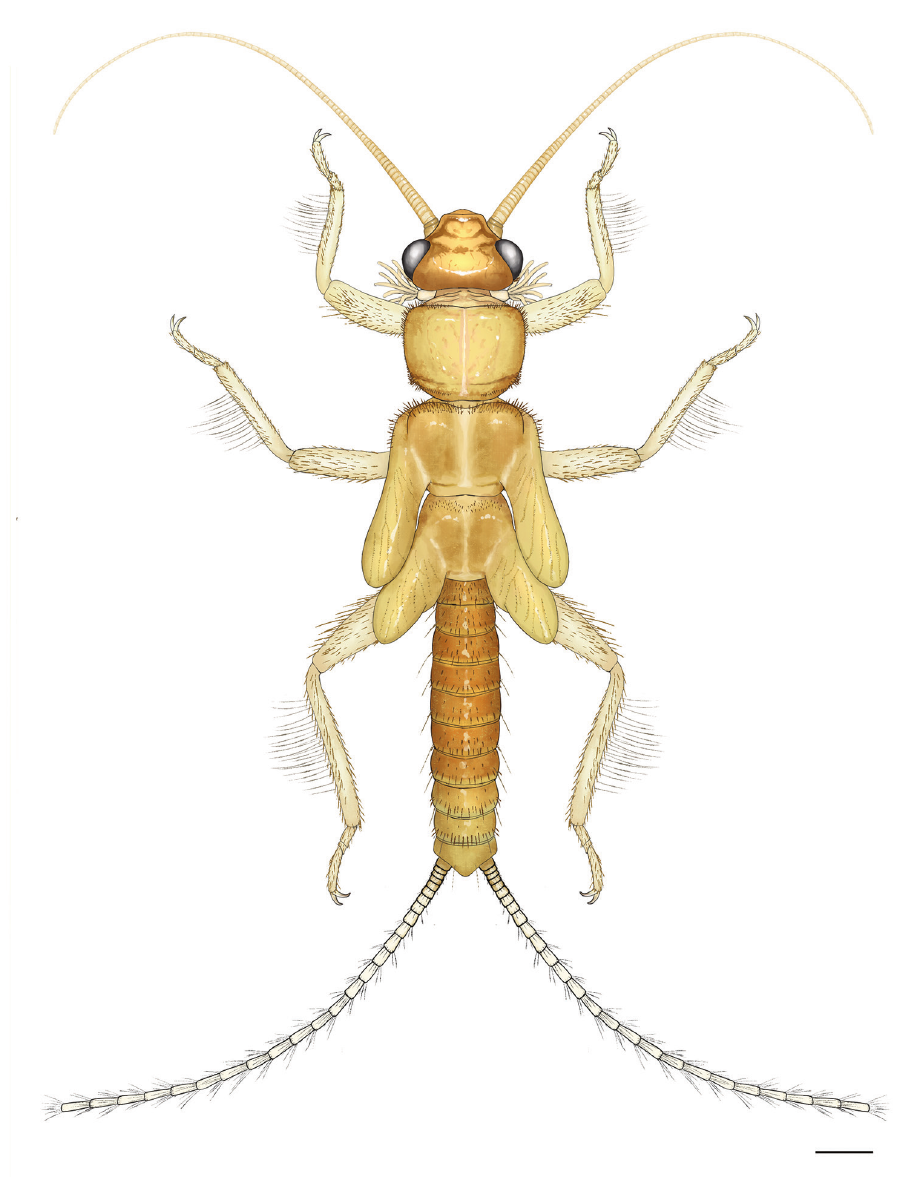
Figure 7. Amphinemura albicauda sp. n., habitus of matured female paratype larva. Scale bar: 0.5 mm. Paragenital plate paired, forming quadrate brownish lobe connected with posterolateral corner of subgenital plate. Sternum IX trapezoidal, median half much protruded anteri- orly, in ventral aspect with anterior indentation. Paraproct and cerci brownish. Female inner genitalia (Fig. 6): Inner sclerite is medially separated into triangular scle- rites located anteriorly to the subgenital plate; anterior portion of the sclerite halves with